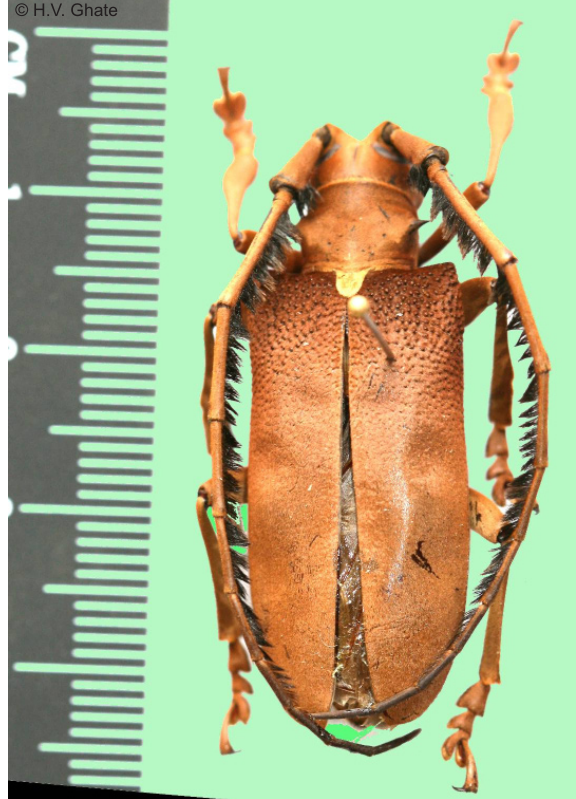
Image 1. Sarothrocera lowii White , dorsal view of female